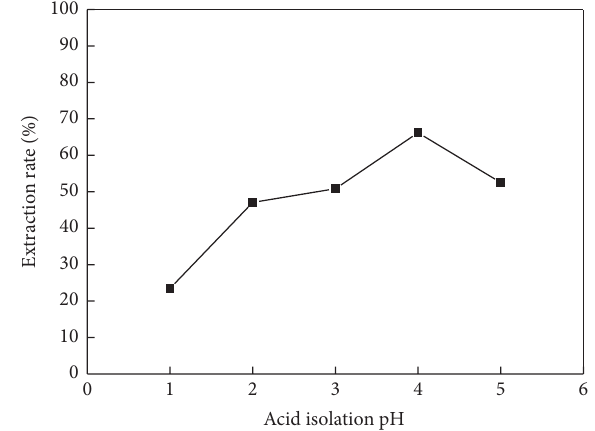
Figure 6: Effect of acid solution pH value on the extraction rate of saponin (liquid-solid ratio 10mL/g, alkali solution pH value 10, extraction temperature 60 ∘ C, and extraction time 60